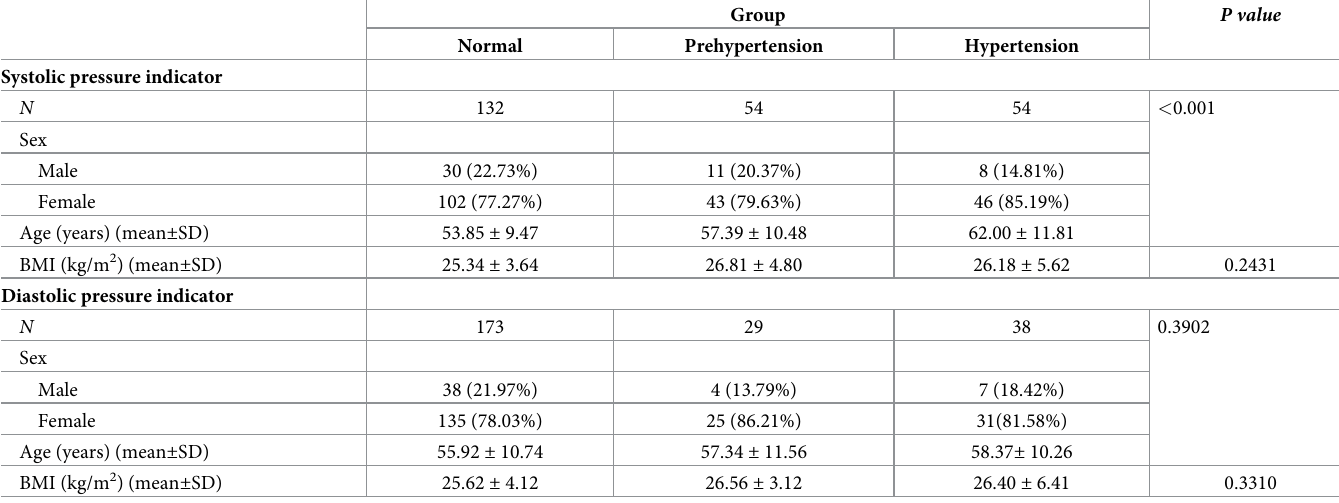
Table 1. Sample size, age, and body mass index (BMI) in each group characterized by the systolic pressure indicator and diastolic pressure indicator.